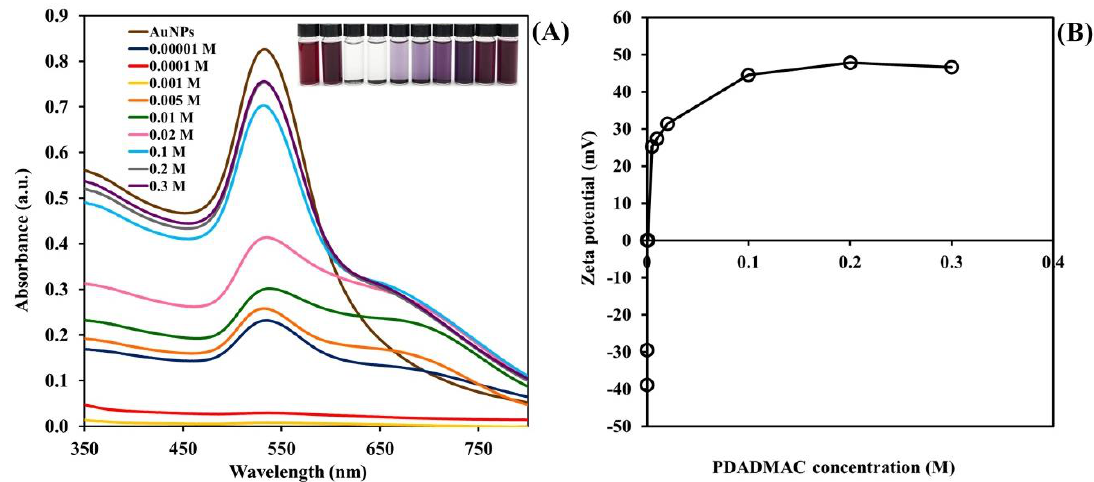
Figure 1. ( A ) Absorption spectra of Au–Ag BNPs and ( B ) Zeta potential of Au–Ag BNPs at different concentrations of PDADMAC.